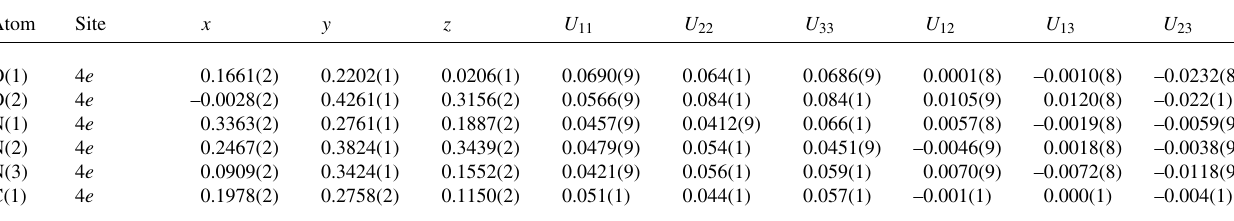
Table 3. Atomic coordinates and displacement parameters (in Å 2 )